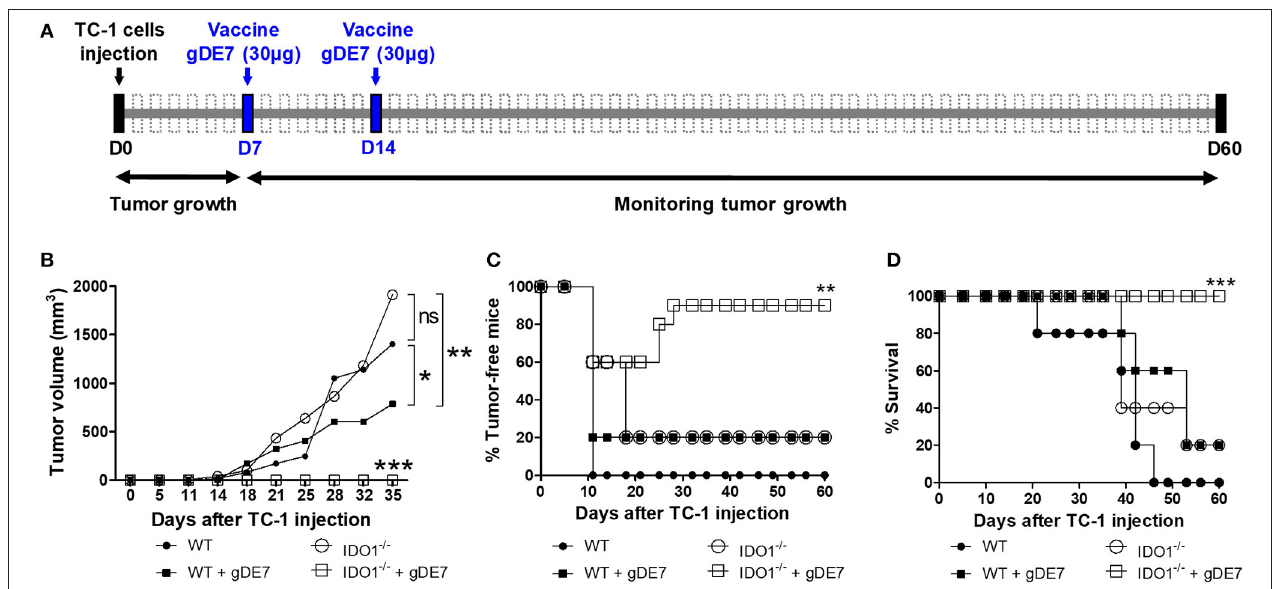
FIGURE 4 | IDO expression impairs the antitumor effects of gDE7-based immunotherapy. (A) Wild-type (WT) and IDO − / − mice were subcutaneously injected with 1 × 10 5 TC-1 cells and immunized with two doses (7-day interval) of gDE7 (30 µ g per animal) via subcutaneous (s.c.) route. Tumor growth was monitored until 60 day, when the animals were euthanized. Antitumor effects were measured by (B) tumor volume, (C) the percentage of tumor-free mice and (D) the percentage of mice survival. Vaccinated IDO − / − mice were significantly different than all other groups, highlighting that the gDE7-dependent antitumor effects are enhanced by inactivation of host IDO gene expression. Data from two identical experiments ( n = 5) were pooled and analyzed by ANOVA or by Kaplan-Meyer test (exclusively for survival assay). * p < 0.05, ** p < 0.01, and *** p < 0.001. (ns) Non-significant. When not signaled, * represents the statistical significance of one experimental group in relation to all